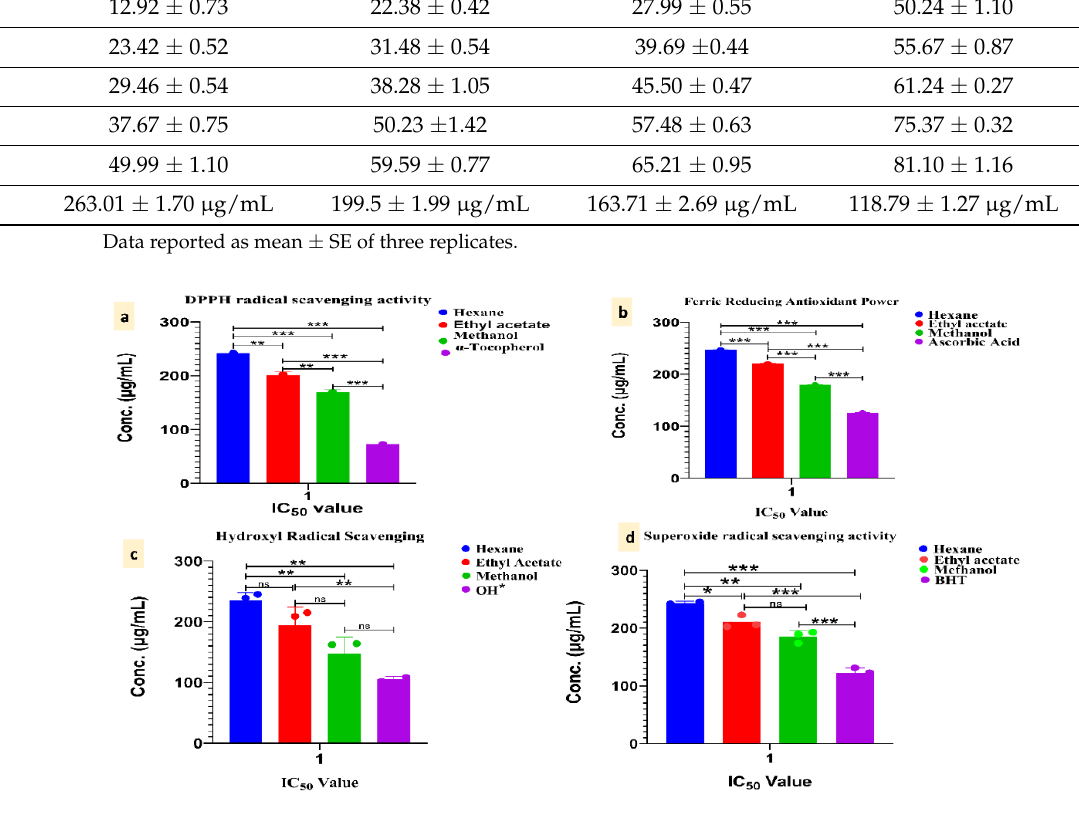
Figure 2. IC 50 value along with Tukey’s multiple comparisons tests: ( a ) DPPH radical scavenging activity, ( b ) ferric-reducing antioxidant power, ( c ) hydroxyl radical scavenging activity and ( d ) superoxide radical scavenging activity. The significance level represented as stars (*** p < 0.0000, ** p < 0.001, * p < 0.01), ns = not Table 3. DPPH free radical scavenging activity of different extracts of A. chasmanthum rhizome.